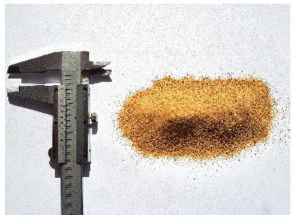
Figure 1. Fine-grained lightweight abrasive